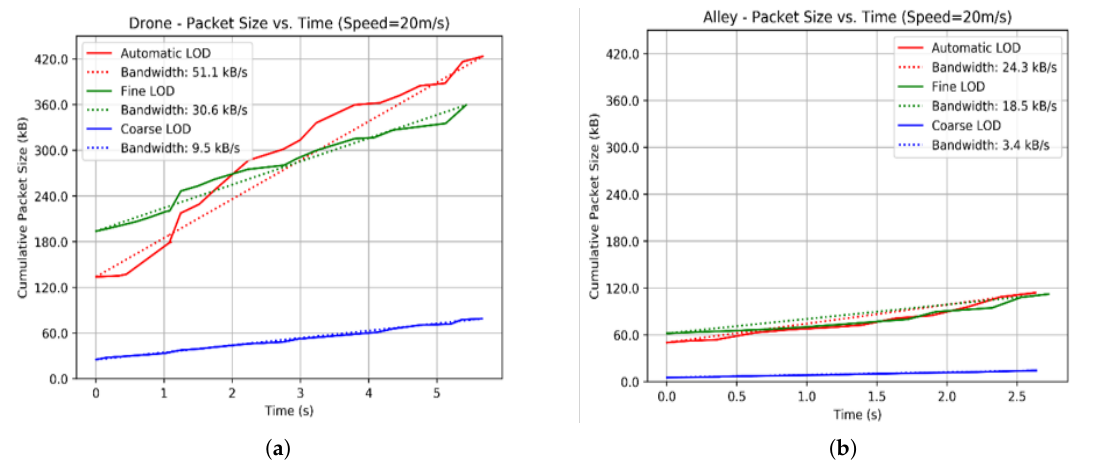
Figure 9. ( a ) and ( b ) Cumulative amount of data and bandwidth required to transmit 3D Tiles Nav. shown in Figure 7 when moving along a path at a speed of 20 m/s. Once the initial map has been uploaded, the required mean bandwidth is shown as a dotted line. The lines correspond to models rendered with fine LOD (green), coarse LOD (blue), and automatic LOD